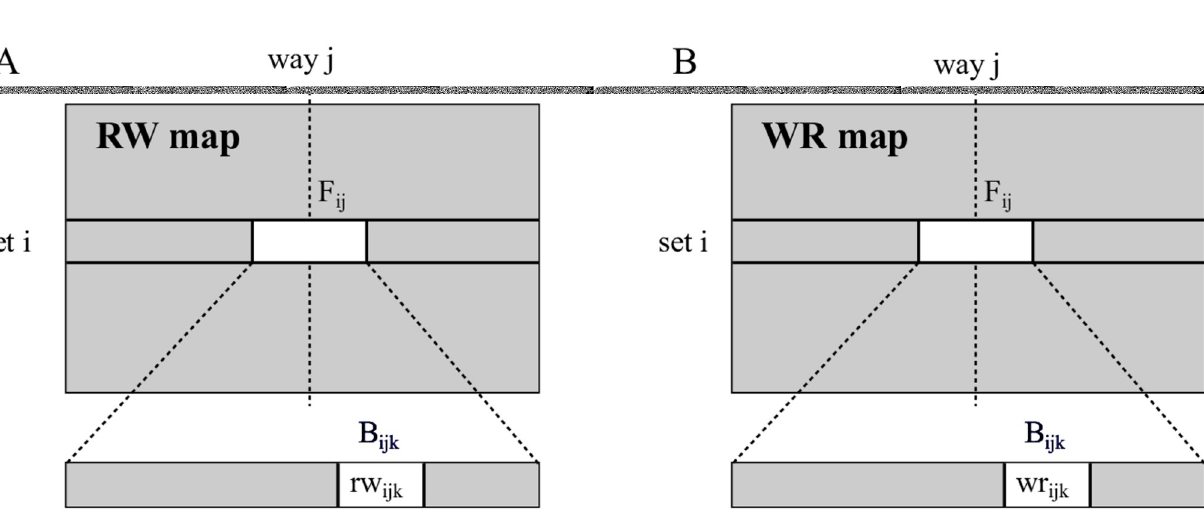
Fig 8. Per-byte Remaining Writes (A) and Write Rate (B)